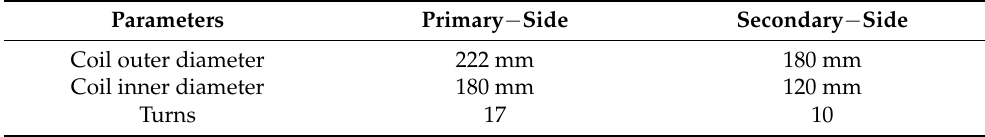
Table 1. Physical parameters of the